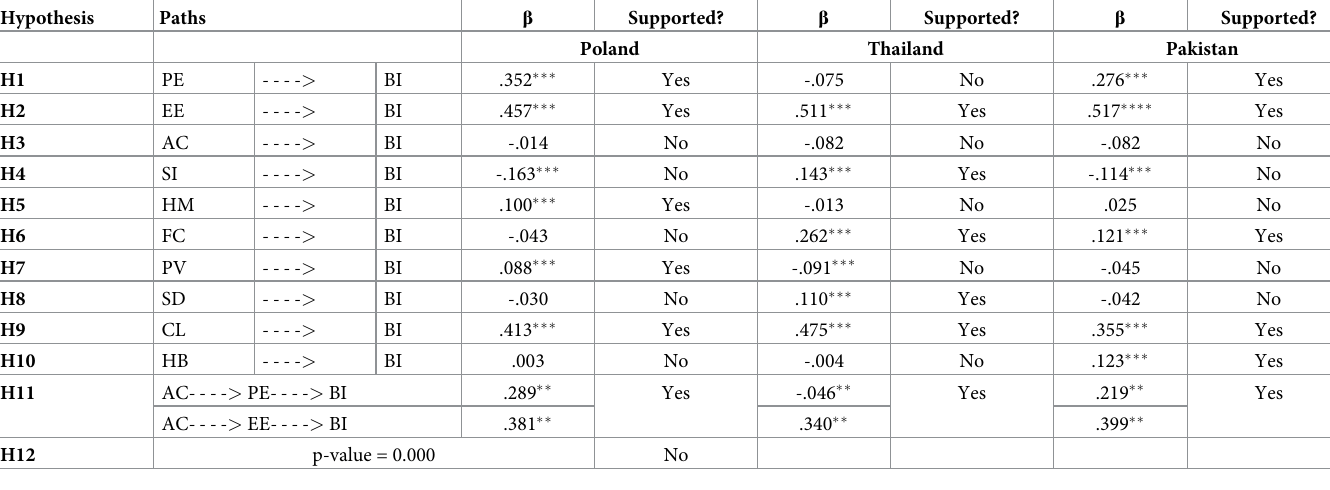
Table 11. Summary of hypothesis results.